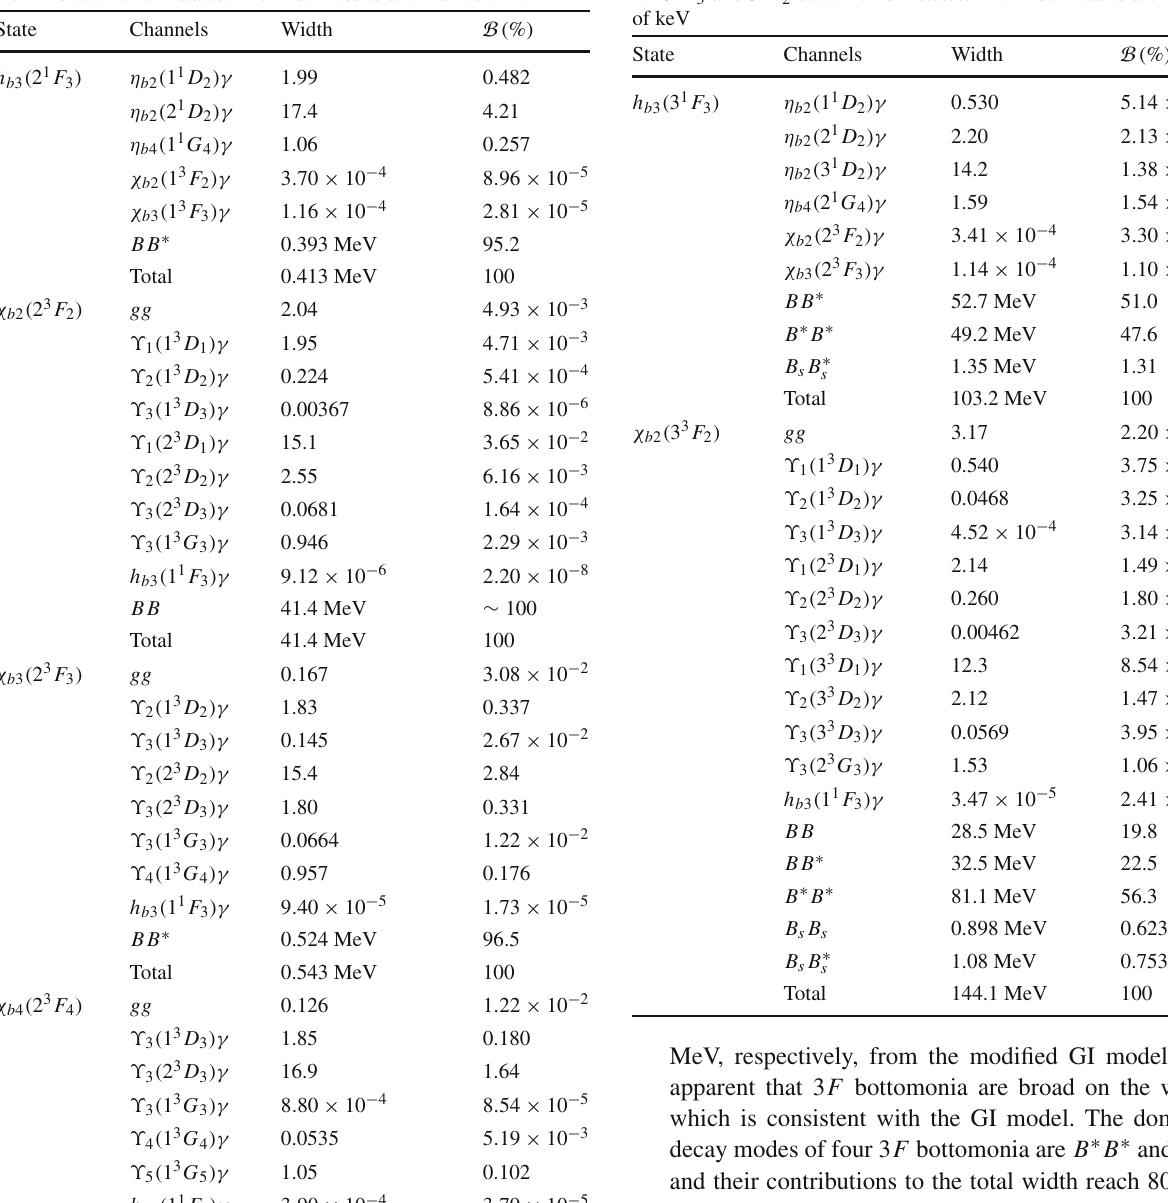
Table33 PartialwidthsandbranchingratiosoftheOZI-allowedstrong decay, annihilation decay, and radiative transition and total widths for the 2 F bottomonium states. The width results are in units of keV